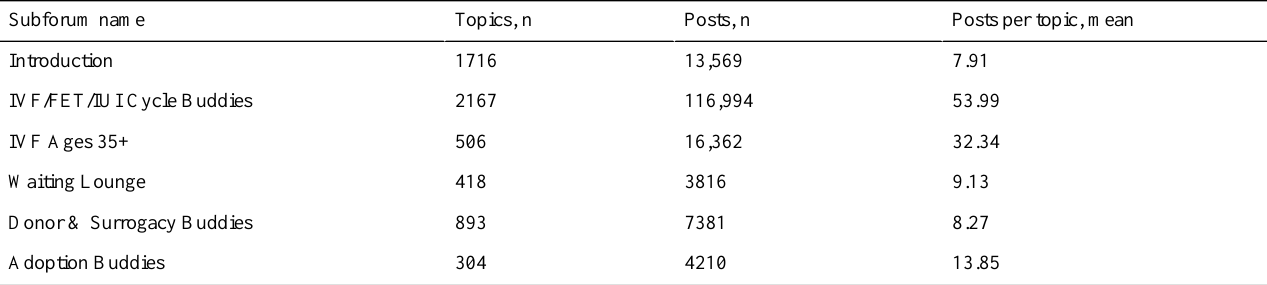
Table 1. Statistics on the analyzed subforums on the IVF.ca website at the time of data collection.